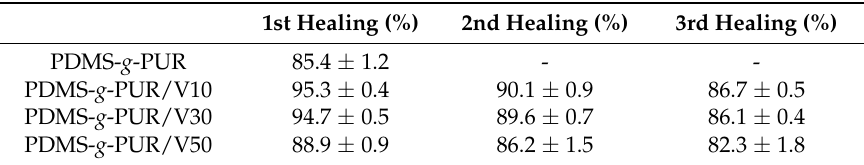
Table 2. Healing efficiencies of PDMS- g -PUR and PDMS- g -PUR/V 2 O 5 composites. 1st Healing